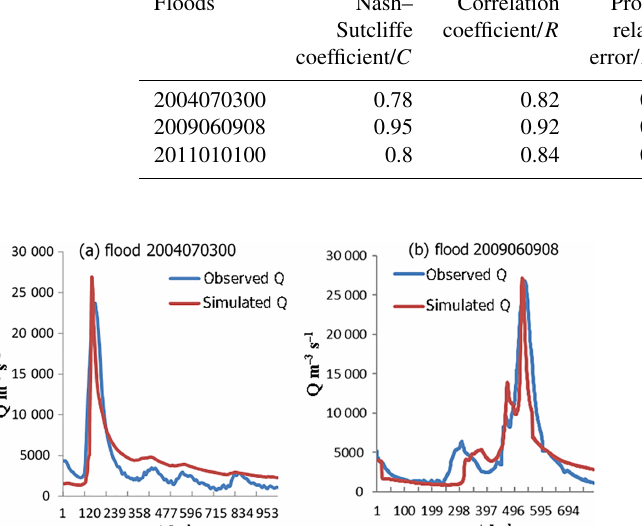
Table 3. The evaluation indices of flood simulation results obtained through parameter optimization by the improved PSO algorithm. Floods Nash– Correlation Process Peak flow The coefficient Peak time Sutcliffe coefficient/ R relative relative of water error/ T (h) coefficient/ C error/ P % error/ E % balance/ W